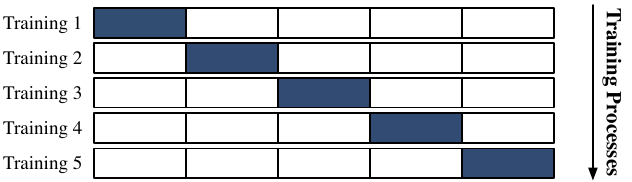
Figure 9. Application of K-Fold. Example of a K-Fold cross-validation; in each training process, the colored subset was adopted as the test